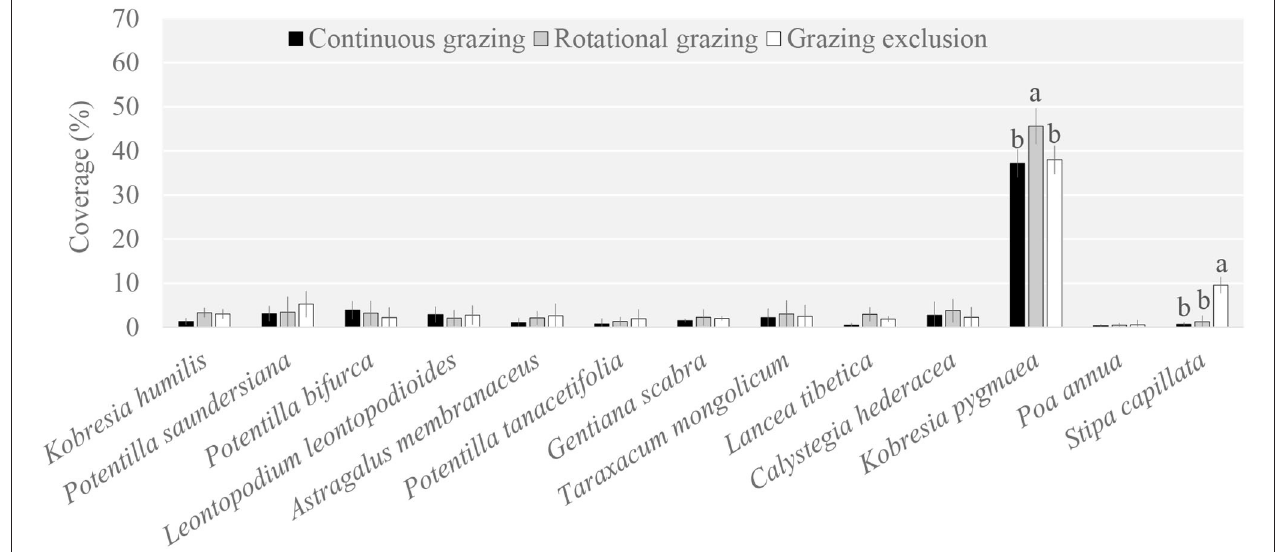
FIGURE 1 | Plant species coverage among grazing regimes. Different lowercase letters indicate significant differences between grazing regimes ( p < 0.05). palatable species for yaks and its coverage under RG was higher than that under GE and CG ( Figure 1 ). Another priming